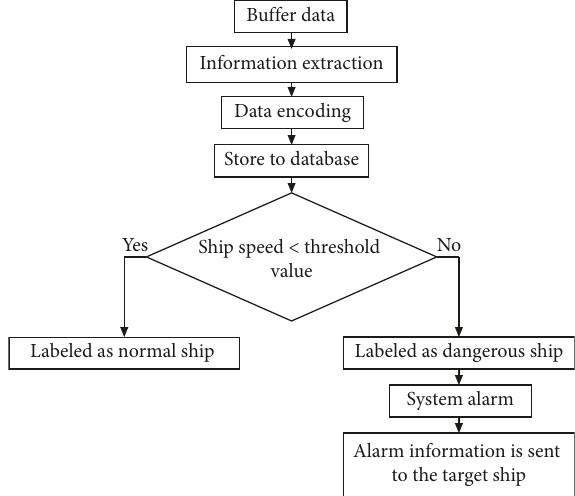
Figure 8: Data flow processing flowchart.